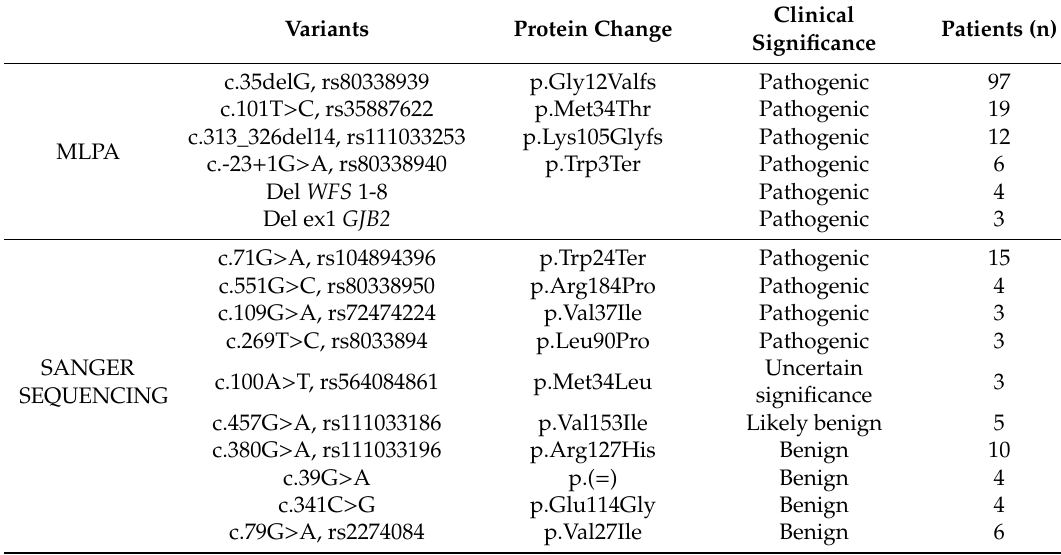
Table 1. Variants spectrum found in this